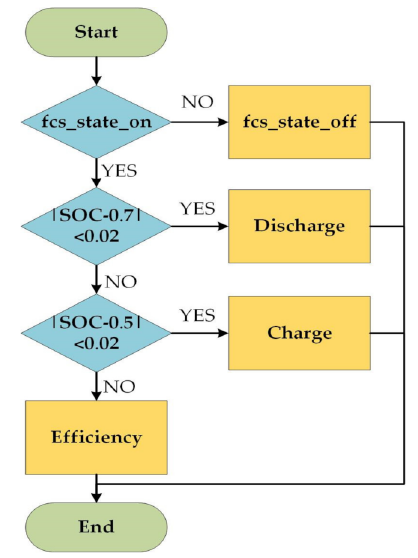
Figure 9. Flowchart of rule-based control strategy in running